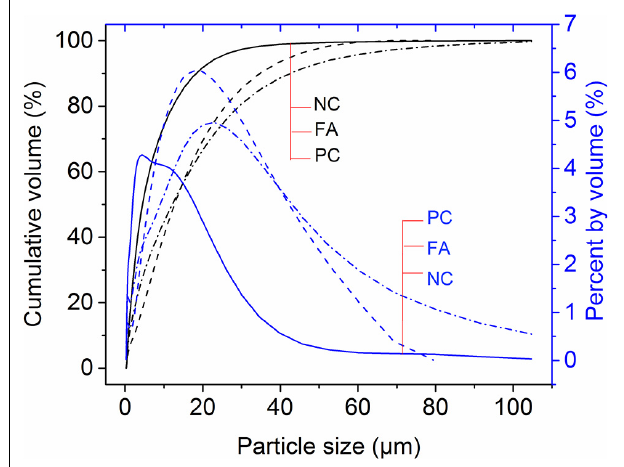
FIGURE 2 | Particle size distribution of PC, nano-CaCO 3 , and fly